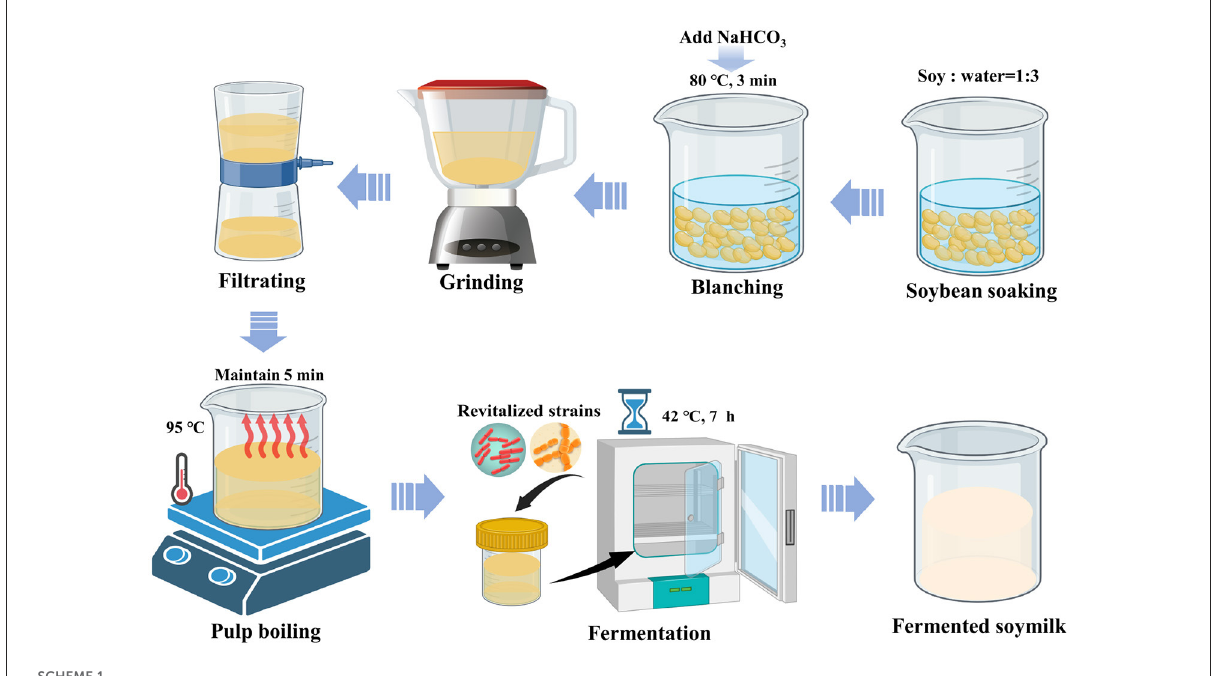
SCHEME1 Fermented soymilk preparation